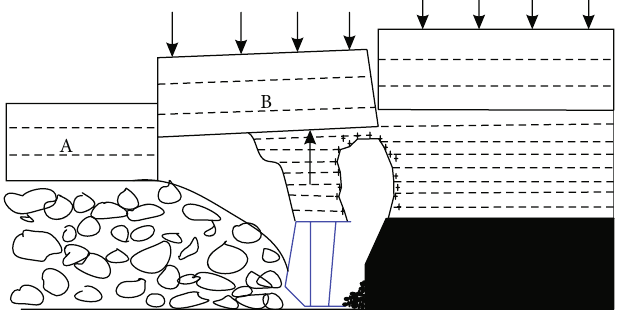
Figure 10: The change of roof structure aggravates the damage.